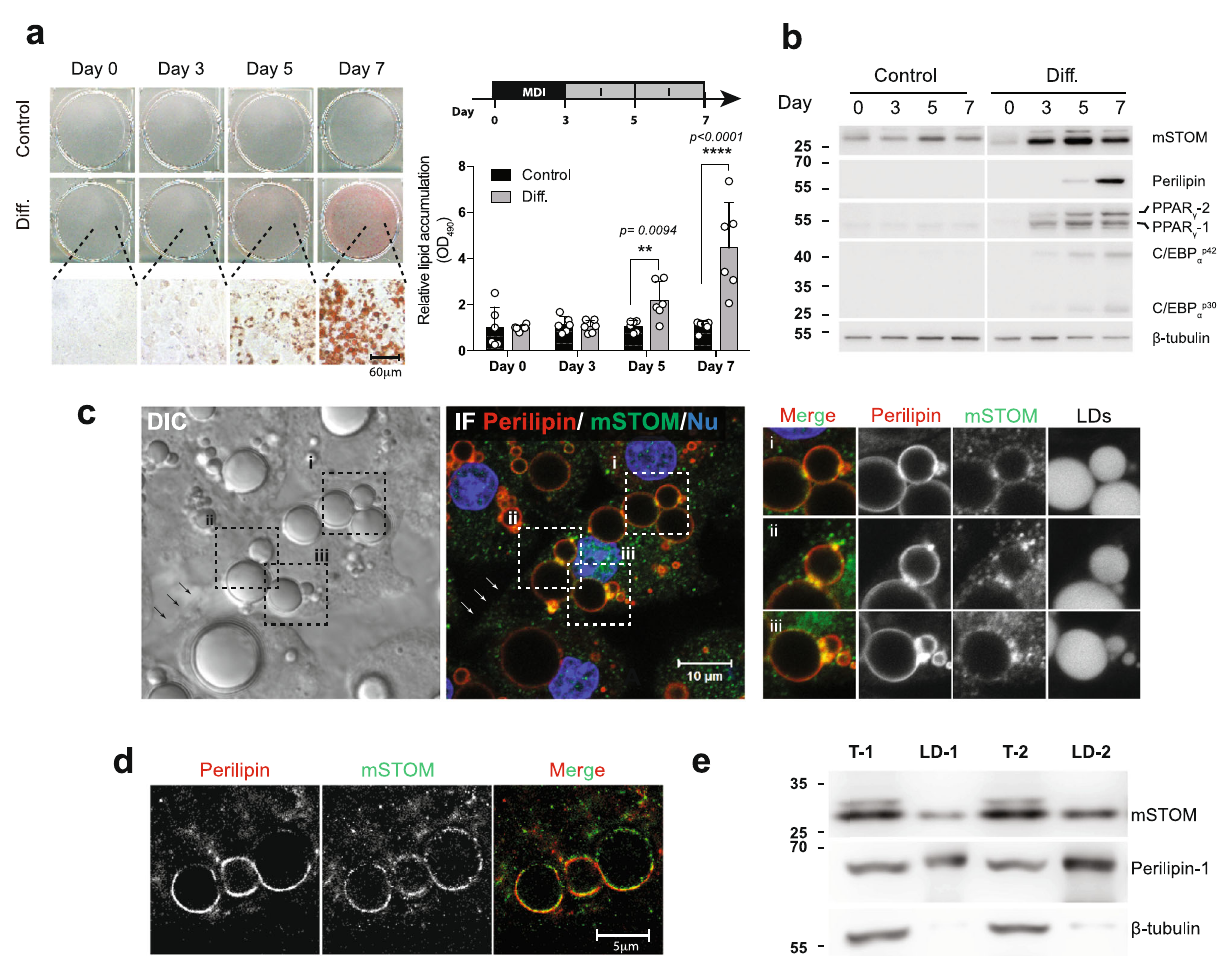
Fig. 1 Stomatin expressions increased during adipogenesis. a Mouse 3T3-L1 fi broblasts were treated with MDI induction medium (Diff.) or control vehicle. On Day 0, 3, 5, 7 after induction, cells were stained with Oil Red O and observed under microscopy. Bar = 60 µ m. The amounts of lipid accumulation for individual culture plates were quanti fi ed by measuring absorbance at 490 nm (OD 490 ). Mean± s.d. for six independent experiments. ** P < 0.01 and **** P < 0.0001 by two-way ANOVA analysis. b On the day after induction as indicated, Western blotting analyses revealed increased expressions of endogenous mouse stomatin (mSTOM), perilipin, PPAR γ and C/EBP α . c Subcellular distributions of stomatin and perilipin in Day 7 adipocyte-like cells were observed by differential interference contrast (DIC) and immuno fl uorescence (IF) microscopy using a confocal microscope. Cell nuclei (Nu) were revealed by Hoechst stain. Stomatin proteins were present on the plasma membranes (arrows) and surfaces of lipid droplet (LD) (inset i-iii). Bar = 10 µ m. d STED microscopy showed that stomatin and perilipin were partially colocalized on the LD surfaces. Scale bar = 5 µ m. e LDs were isolated and subjected to immunoblotting analyses. Stomatin and perilipin proteins, but not β -tubulin, were identi fi ed in the LD fractions (LD-1 & LD-2). Source data are provided as a Source data fi le. STED: stimulated emission depletion; T-1 & T-2: total cell Fluorescently labeled palmitic acid analogs Bodipy-FL-C 16 , when yellow LD (arrows, Fig. 2g) as they contained both fl uorescent fatty acid analogs. The degrees of LD-LD fusion could be added to the culture medium, were internalized by 3T3-L1 adi- quanti fi ed by calculating % fused LDs. Since stomatin could be pocyte-like cells. The uptake process could be continuously excreted to the culture medium 6 , we noticed that adding monitored by measuring the increase of intracellular fl uorescence conditioned medium obtained from cells over-expressing stoma- (Fig. 3b). Adipocyte-like cells over-expressing stomatin exhibited tin (CM-hSTOM) resulted in increase of % fused LDs, compared more and faster fatty acid uptake (green, upper traces) than the to the conditioned medium harvested from the control cells (CM- control cells (blue, second traces). Such an effect was not caused Ctl). Interesting, depletion of stomatin by treating the condi- by the diffusion. No signi fi cant change could be found in the tioned medium with anti-stomatin antibodies effectively inhibited Bodipy-FL uptaking ef fi ciency between the over-expressing sto- such fusion-promoting activity (Fig. 2g). matin (gray traces) and control adipocyte-like cells (black traces). STOM recruits to the plasma membrane and interact with CD36 . Stomatin not only promoted fatty acid uptake, but also 183 proteins (about 21%) were present on plasma membranes redistributed from LD surfaces to the plasma membranes during (PM). Two such stomatin-associated PM proteins, CD36 and this internalization process. As shown in Fig. 3c, when treating cells caveolin-1 (CAV1), played important roles in lipid storage 36 . The with BSA as a control, stomatin proteins were present in high molecular interactions between stomatin and CD36 were abundance surrounding LDs in about half of the adipocyte-like cells demonstrated by immuno-precipitation experiments (Fig. 3a). examined. However, when treating these cells with BSA-conjugated